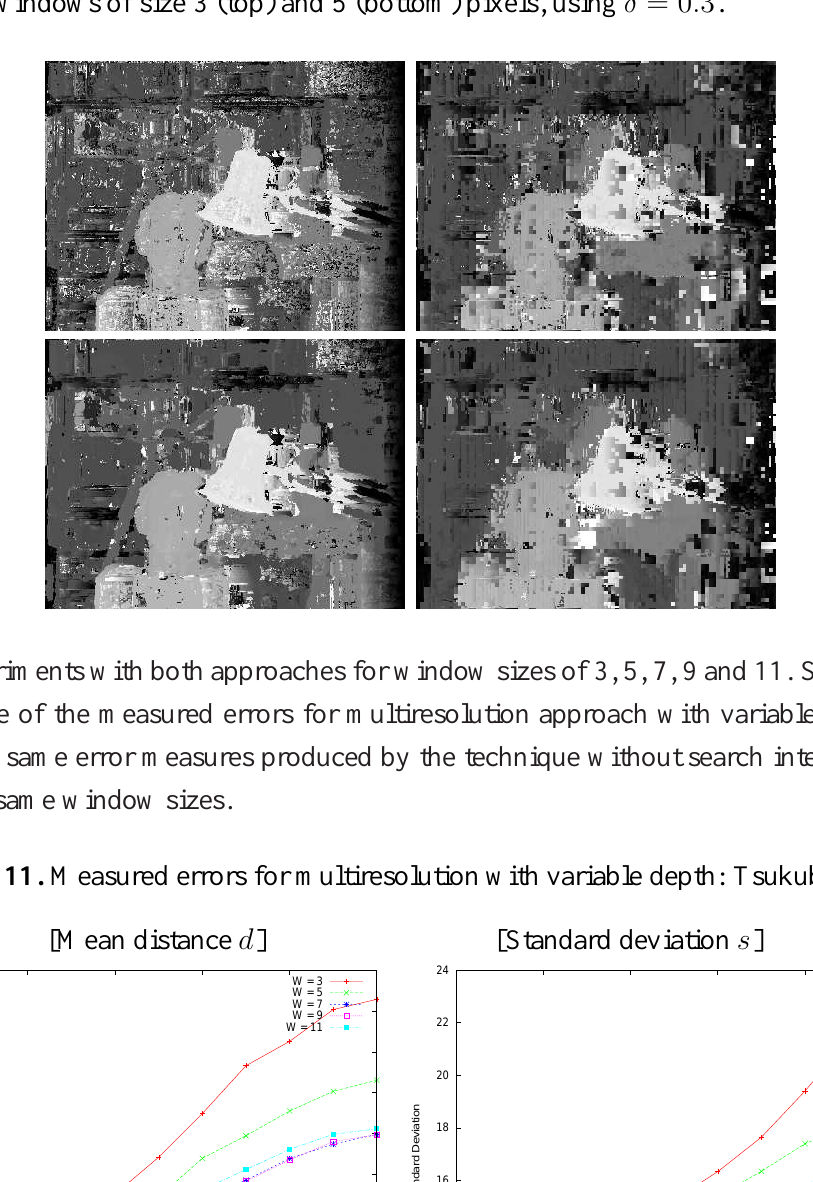
Figure 10. Disparities obtained by plain correlation (right) and multiresolution (left) with correlation windows of size 3 (top) and 5 (bottom) pixels, using δ = 0 . 3 .